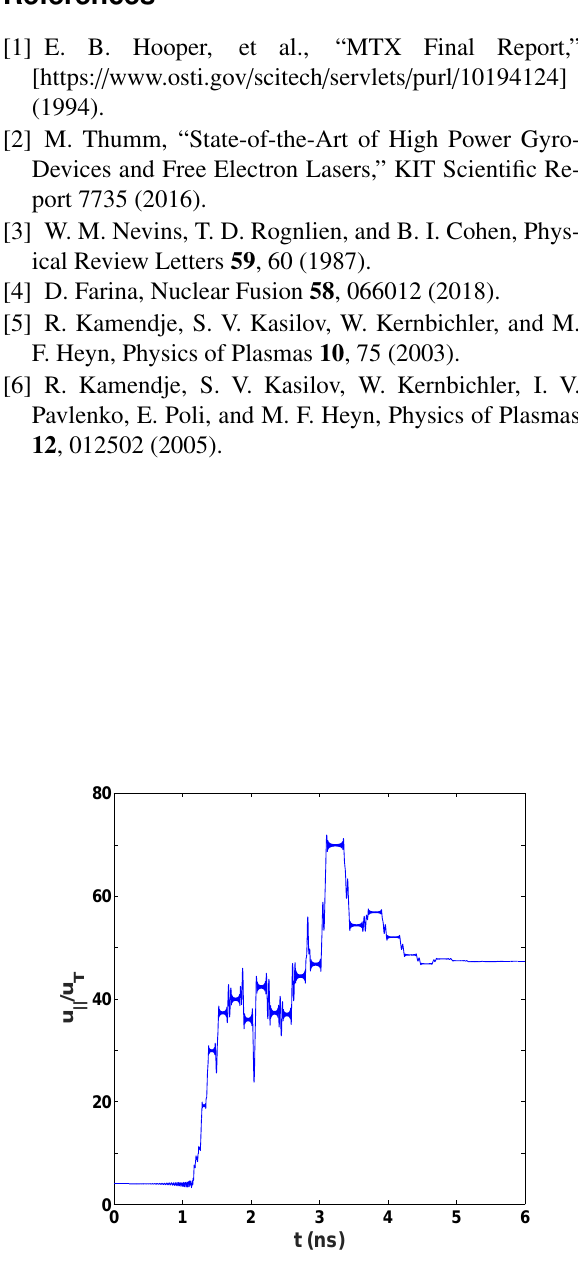
Figure 5. Same as Fig. 1 except that the beam polar- ization is of the extraordinary EC